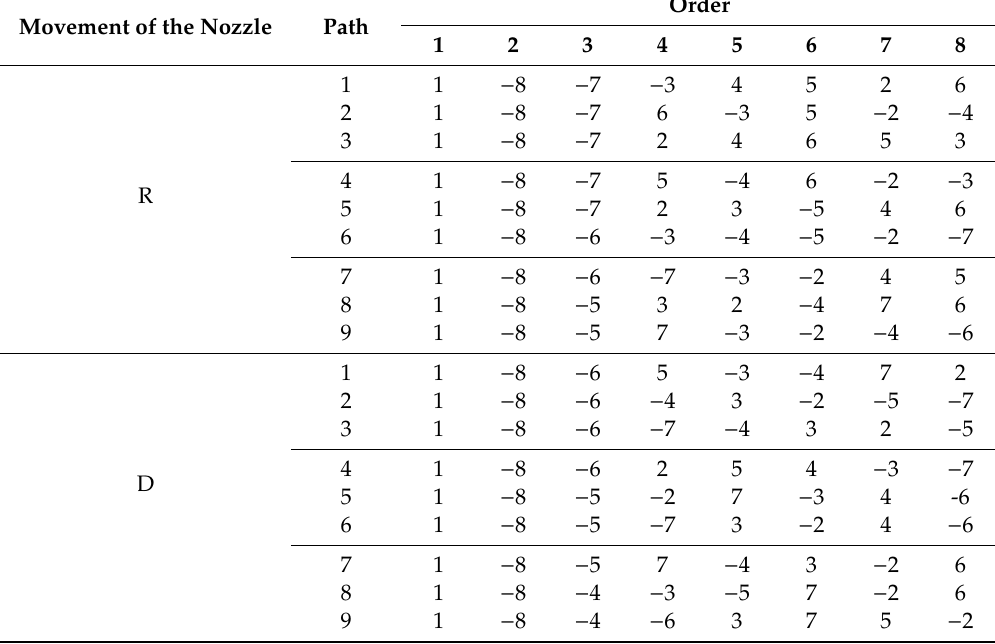
Table 7. Solutions with 1, − 8 start for Example 2 (eight-wall flat). On top ® diagonal movements are not permitted; at the bottom (D) diagonal movements are permitted. T = 35 for all solutions shown. Movement of the Nozzle Path